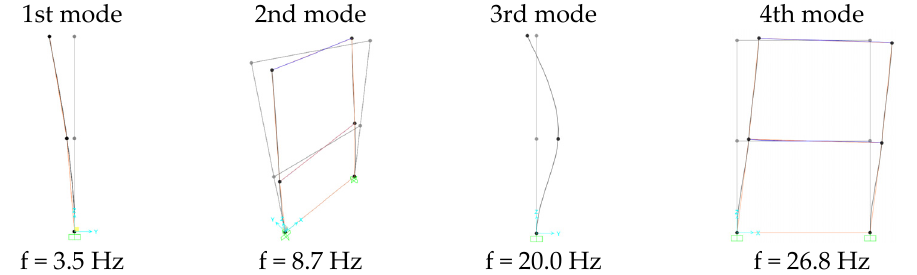
Figure 2. Theoretical modal shapes for the 2D RC frame specimens.